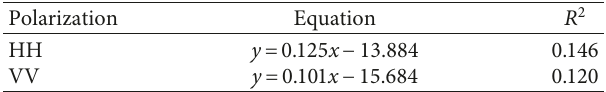
Table 3: Linear fitting equations for in situ SMC and GF-3 radar backscattering coefficient σ ° .